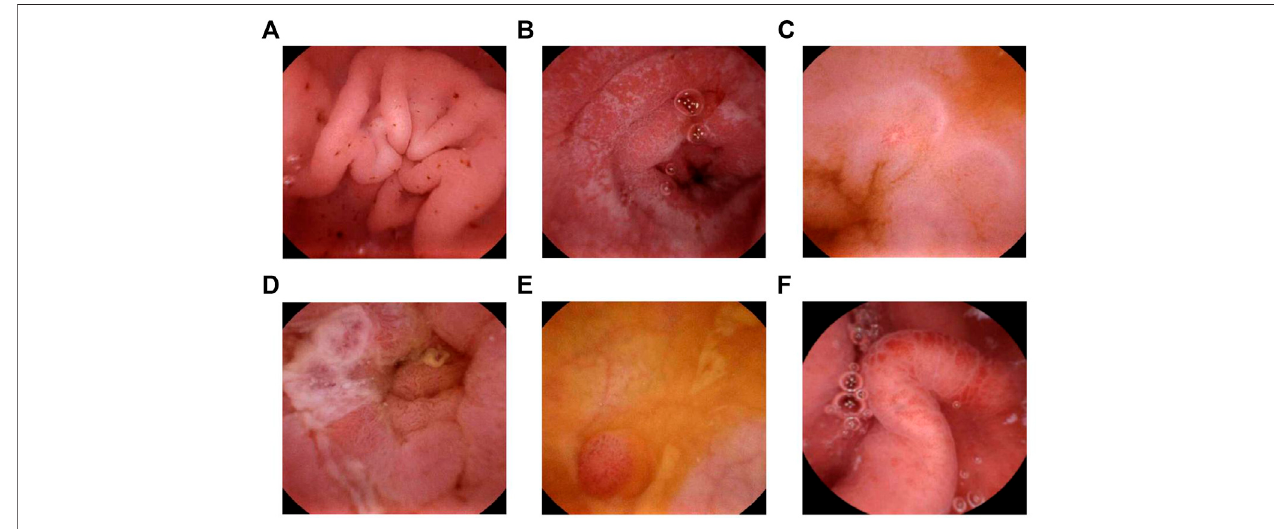
FIGURE1| MGCEimage. (A) Multiplebleedingspotsinthegastricantrum. (B) Frost-spotshapeulcersinthedescendingpartoftheduodenum. (C) Asmallulcerin the jejunum. (D) An ulcer covered with white moss in the jejunum. (E) Fingerlike polyposis in the ileum. (F) Congestion and edema in the